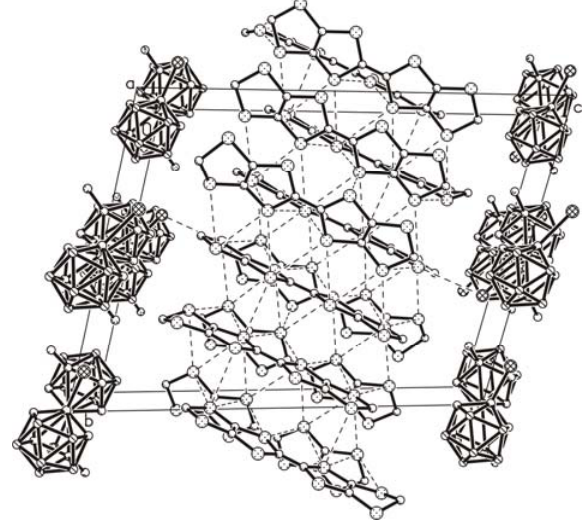
B H ) ] ( 3 2 9 10.06 2